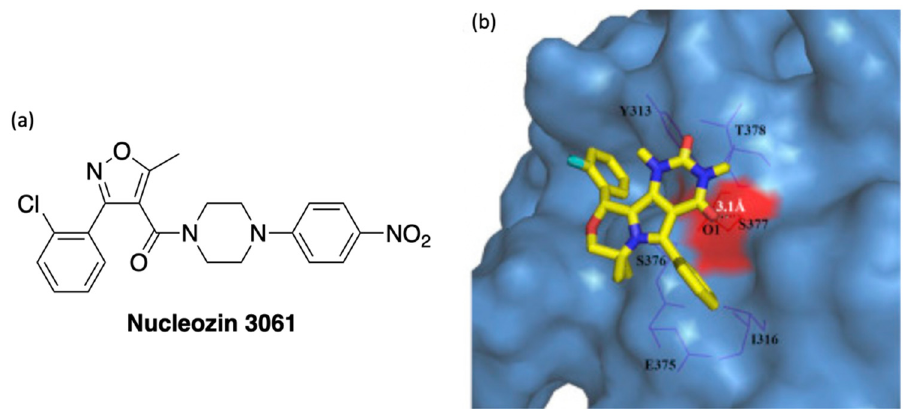
Figure 5. ( a ) Chemical structure of nucleozin 3061. ( b ) The molecular docking study of compound 29 in the influenza A NP [34].